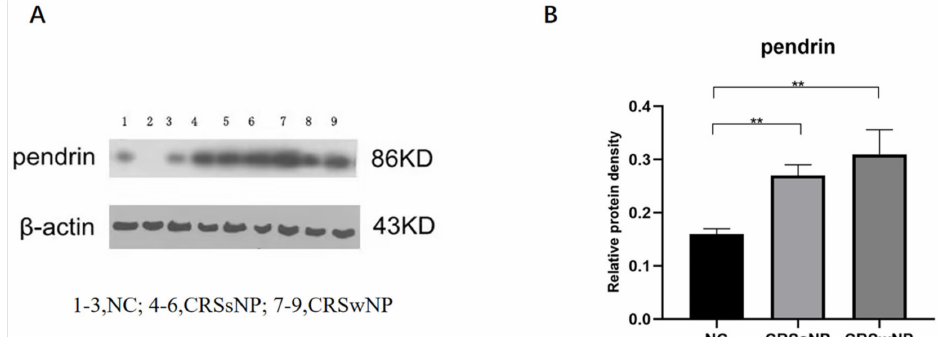
Figure 1. Pendrin protein expression in nasal samples revealed by Western blot (WB). ( A ) is the pendrin expression in tissuse, ( B ) is the density of ( A ) pendrin. ** represents p < 0.01.